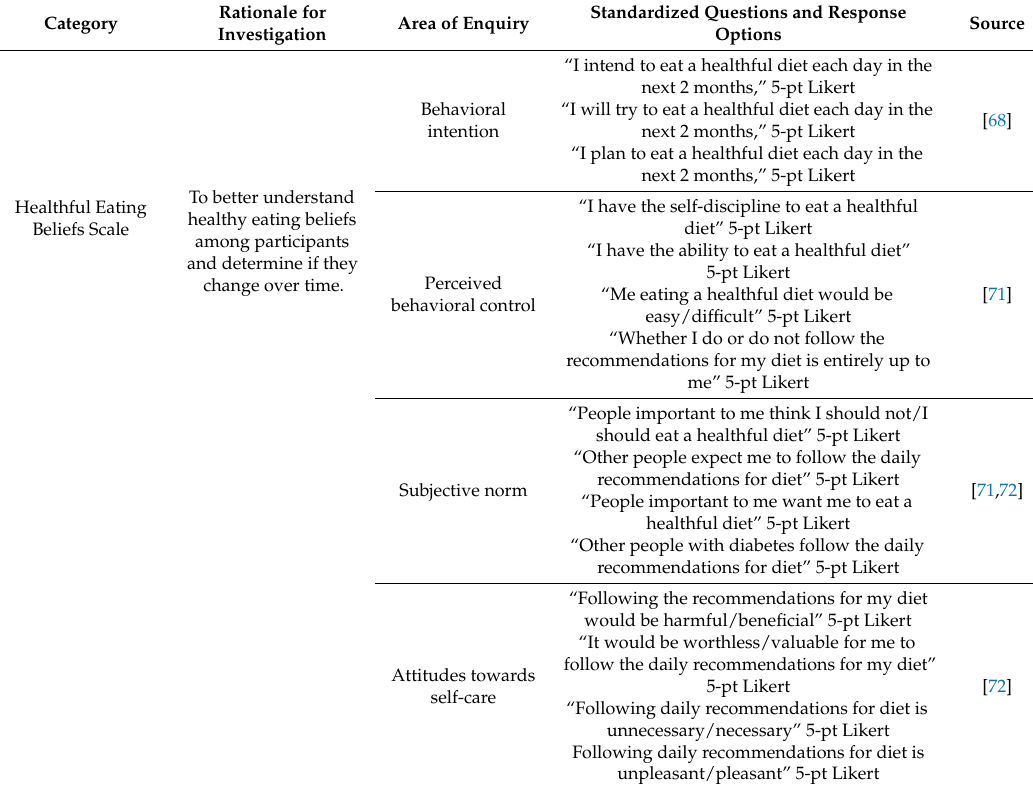
Table 4. Healthful Eating Beliefs Scale rationale for investigation and modes of